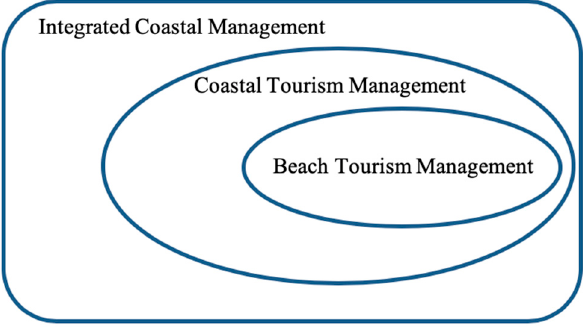
Figure1. Figure 1. Example of the hierarchy required in the management of the coastline for tourism purposes [34].